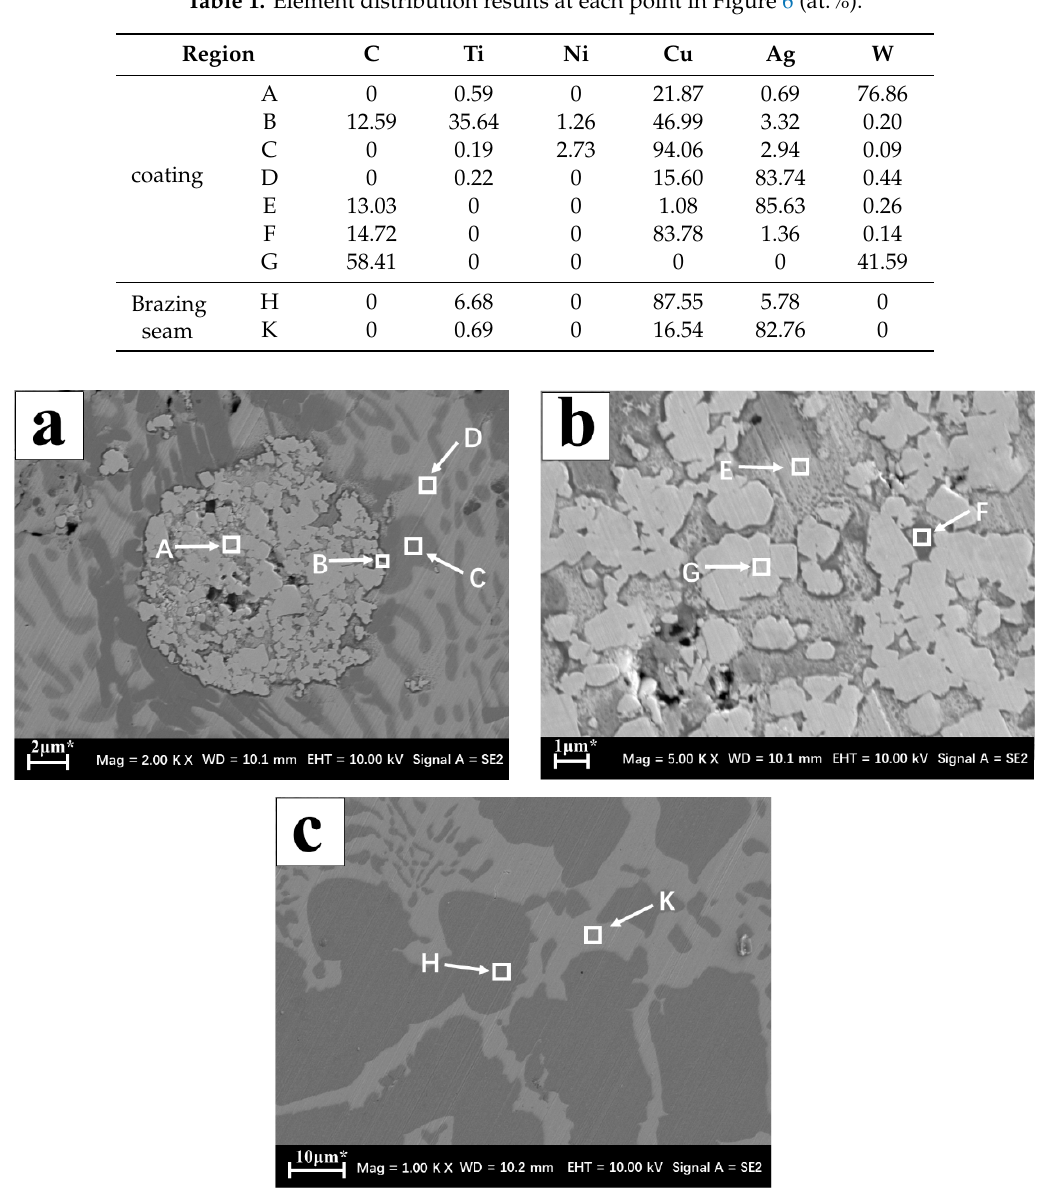
Figure 6. Coating microstructure ( a ) Inside the coating; ( b ) WC enhances the interior of the particle; ( c ) Brazing seam interior. ( c ) Brazing seam